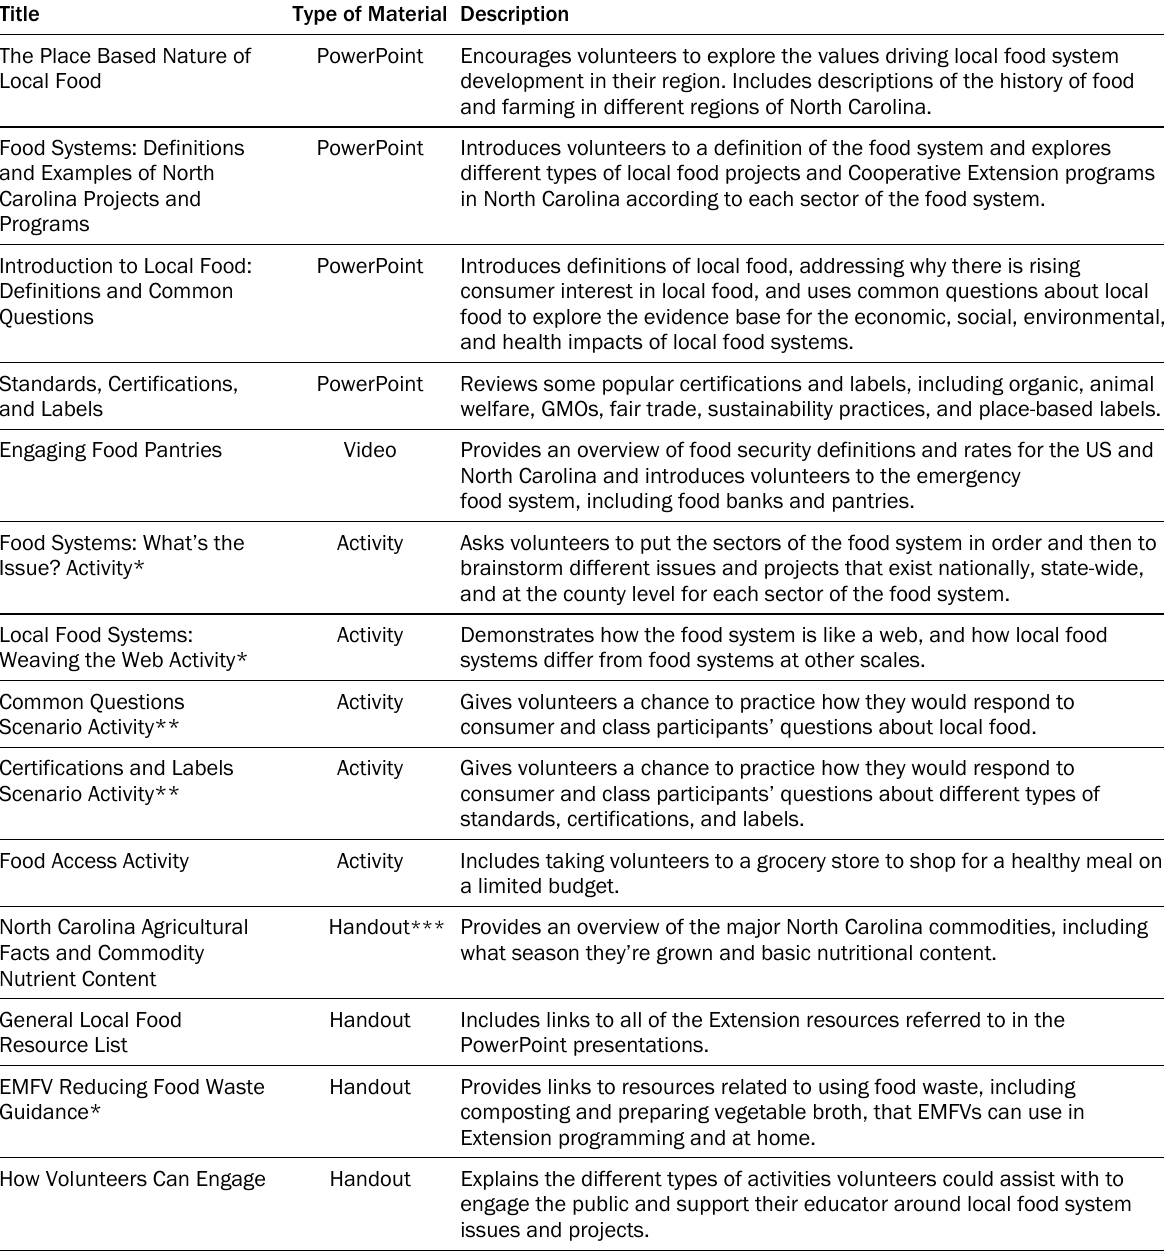
Table A1. Contents of the EMFV Food Systems and Local Food